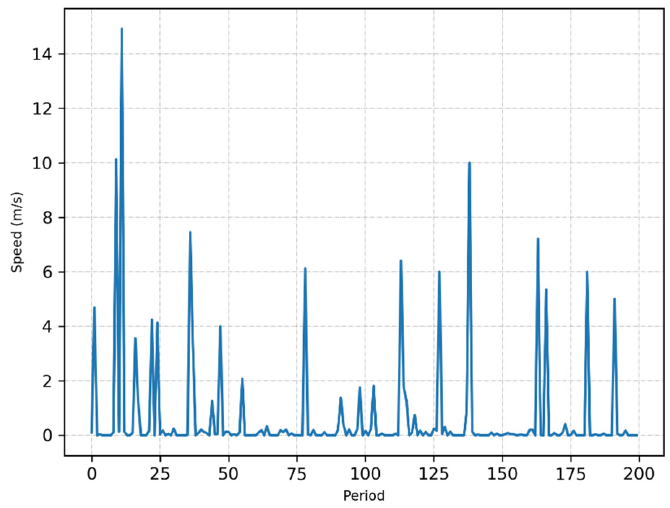
Figure 7. The speed of the UAV.